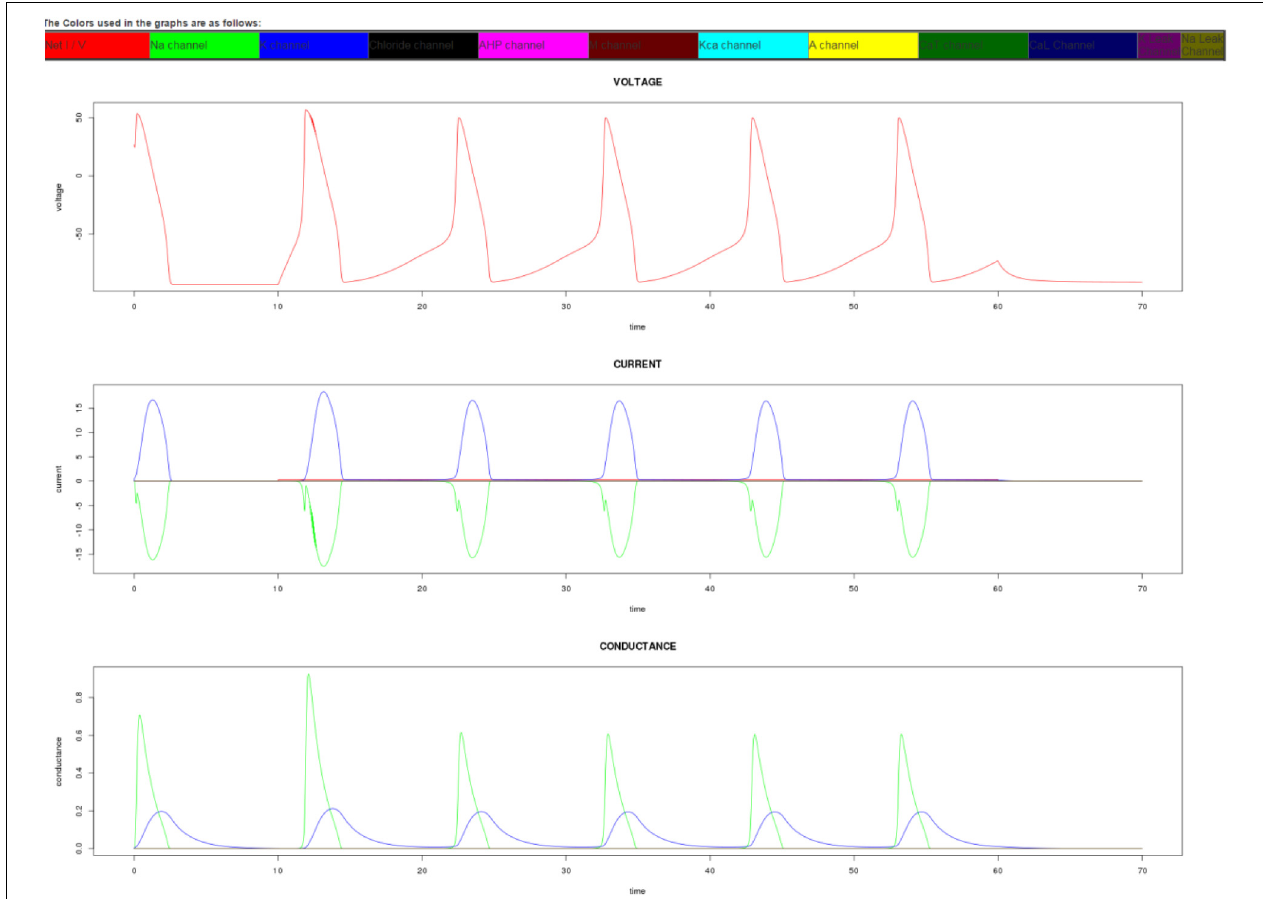
FIGURE 3 | Output graphs of the app on a desktop. The simulator gives as output the time series representation of voltage, current, and conductance. The lines in the graph are color coded to represent different ion channels. In this graph, only sodium and potassium channels have been activated. The output graphs can also be replicated by downloading the CSV file and using a spreadsheet program to draw the